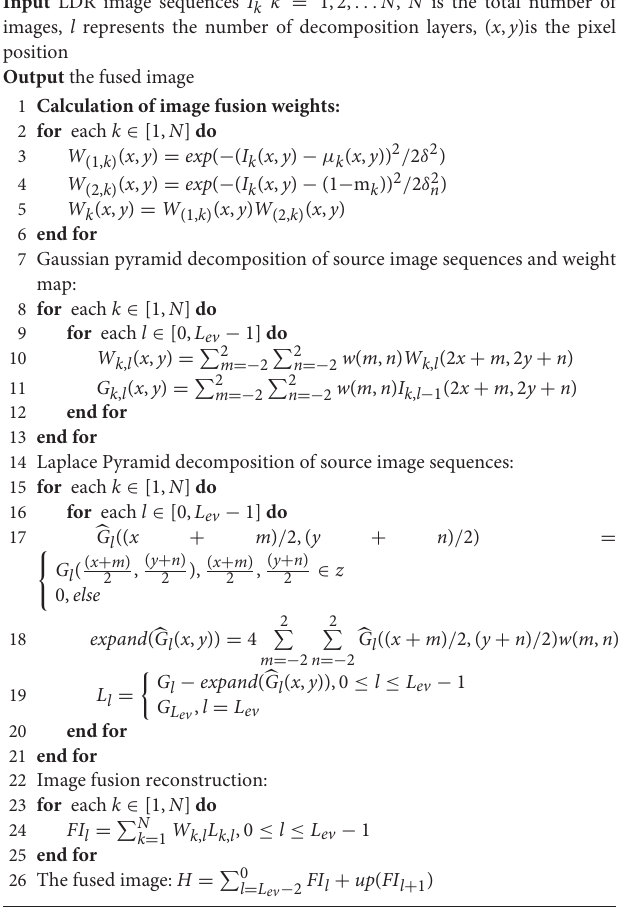
Algorithm 1| Multi-exposure image fusion algorithm based on improved weight function.